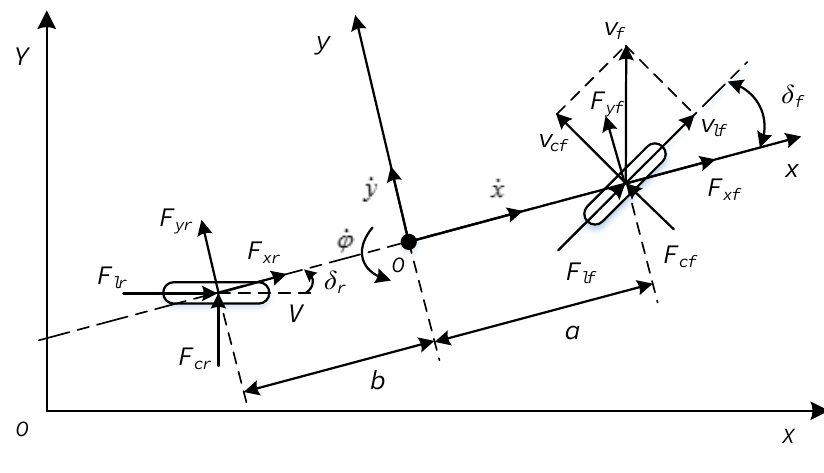
Figure 13. The bicycle model.